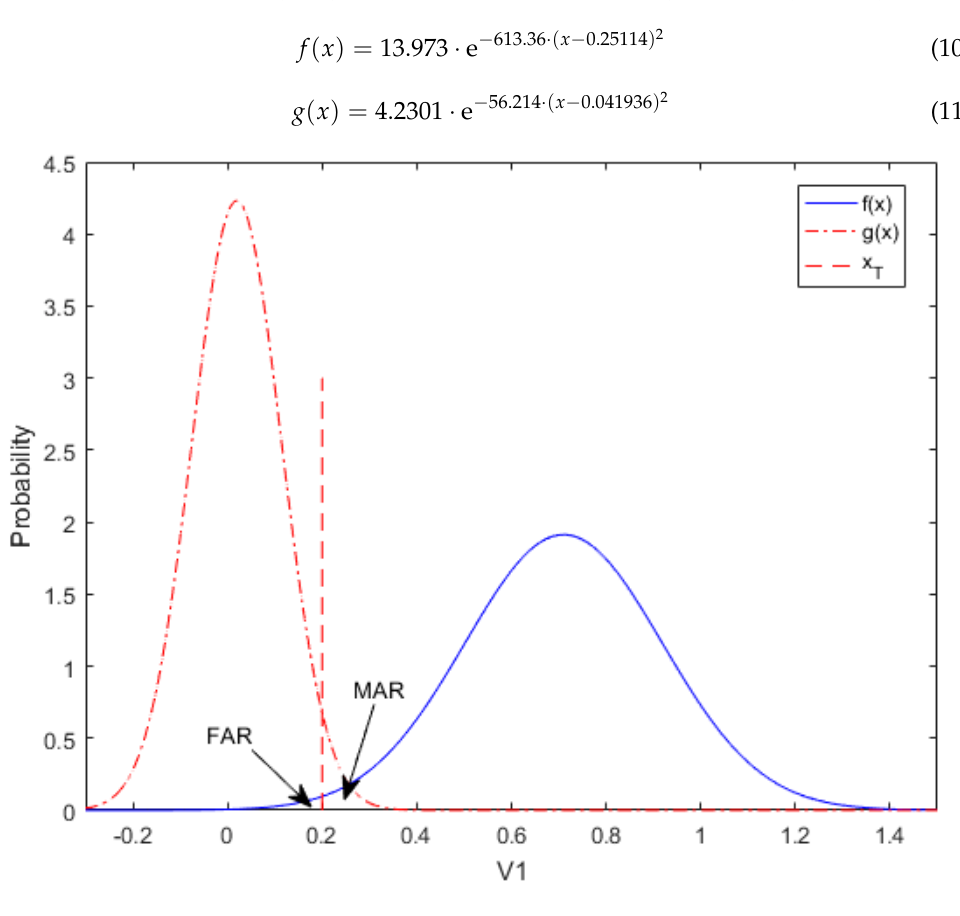
Figure 5. Process probability density curves of V1. Second, the objective function is obtained as Equation (12), the parameters of which, including weight w 1 = 0.521, Equations (1) and (2), R FAR = R MAR = 0.01, are input into function Equation (9).